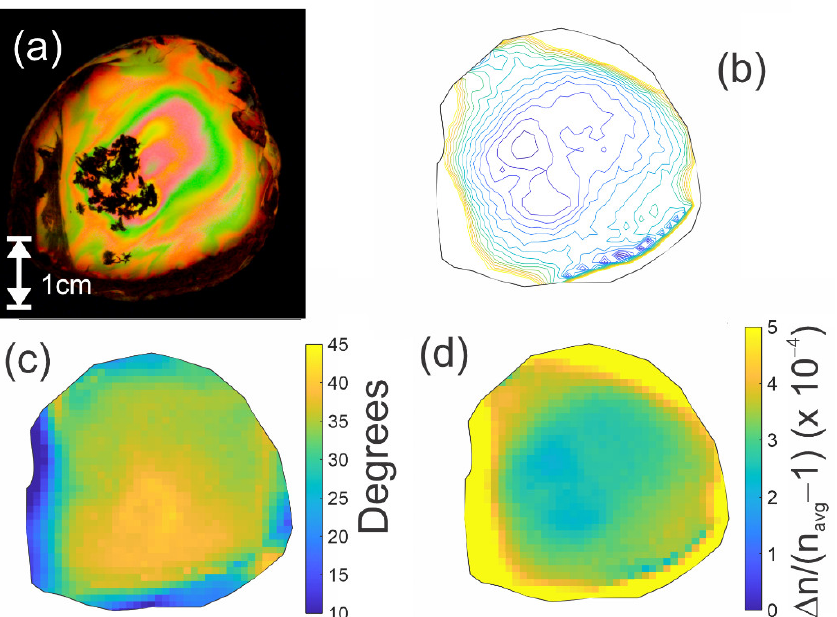
Figure 7. Terahertz birefringence images of Mexican amber sample. ( a ) Visible birefringence image. ( b ) Calculated contour map of stress in the terahertz range using Equation (7), as described in the text for comparison with visible stress image. The contour lines are in arbitrary units with a separation of 1 × 10 − 4 between lines. ( c ) Stress direction image. ( d ) ∆ n /